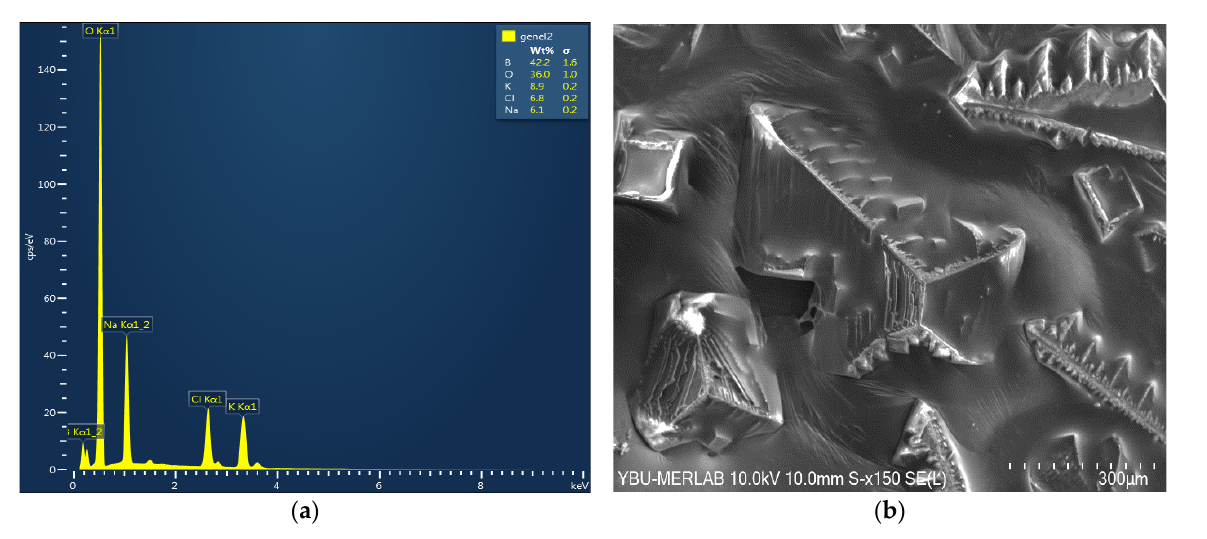
Figure 4. SEM/EDS analysis of KBH 4 hydrolysis products in an acidic medium: ( a ) EDS data and ( b ) SEM images of the remaining solutions after the reaction.